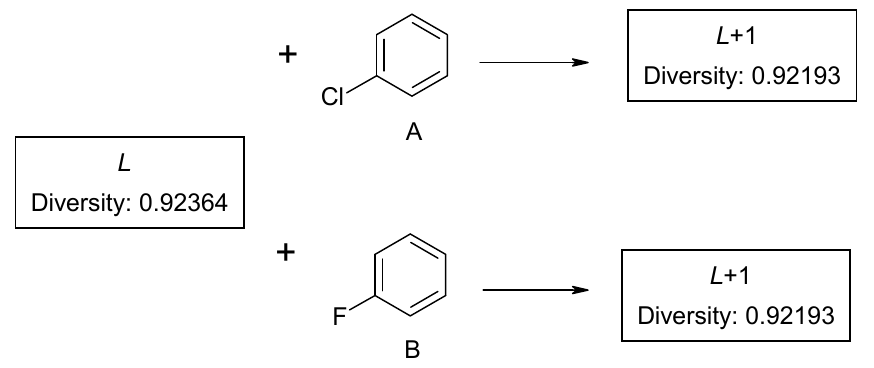
Figure 2. Ambiguities in Maximum Dissimilarity Selection